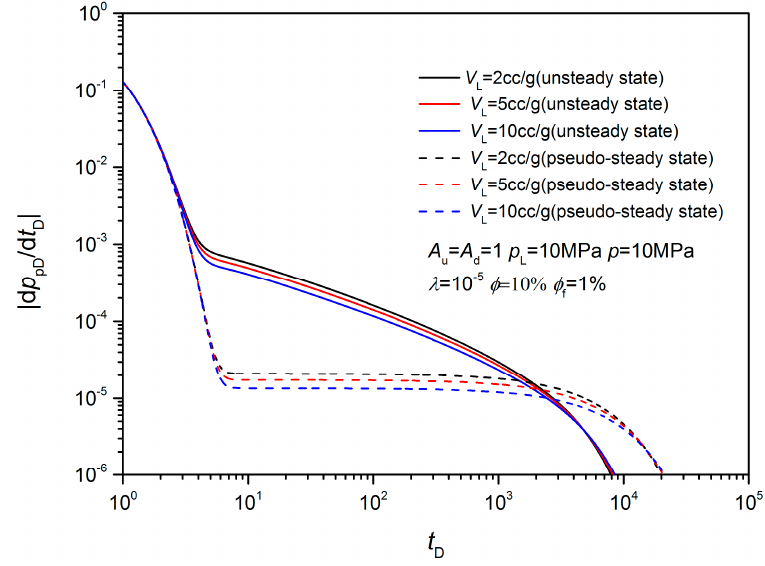
Figure 18. The pseudo-pressure derivative at the late stage. Energies 2019 , 12 , x FOR PEER REVIEW